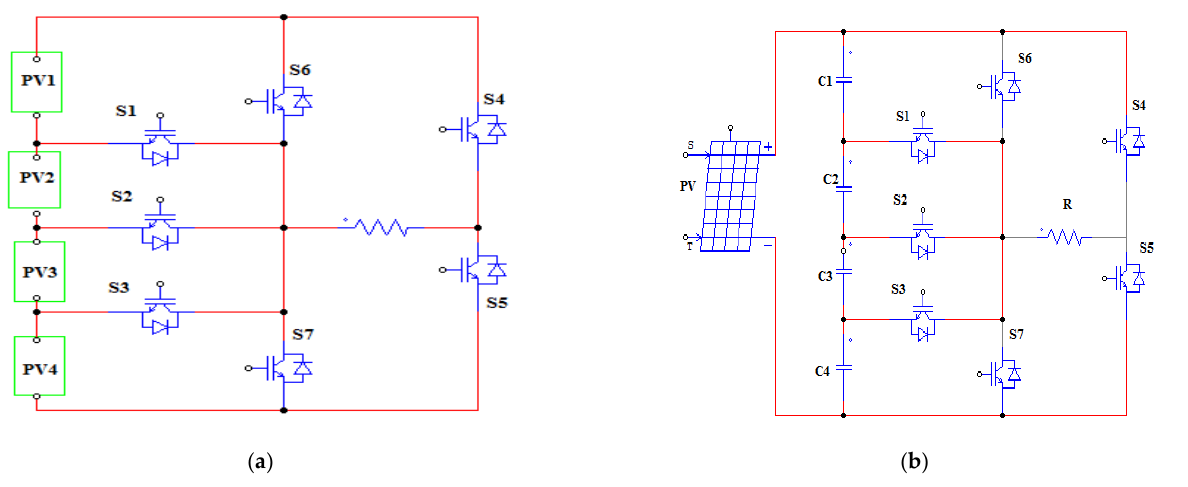
Figure 16. Nine-level, seven-switch proposed topology ( a ) based on four series of DC sources and ( b ) on a single DC source and four capacitors.